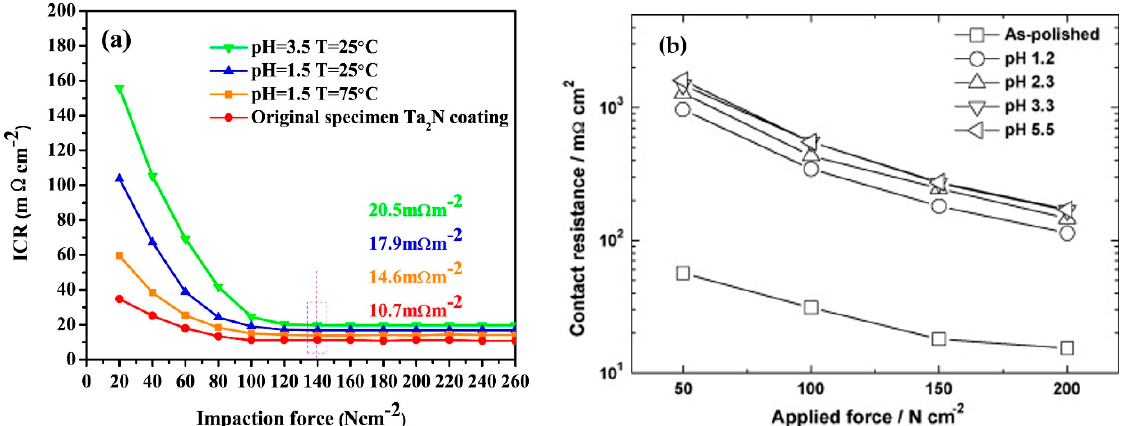
Figure 13. ( a ) Ta 2 N coated Ti-Al6-V4 alloy before and after PST test in 0.05 M H 2 SO 4 with 2 ppm HF. Reprinted from [31] copyright (2016), with permission from Elsevier. ( b ) Effect of pH and temperature on contact resistance- 310S steel on 0.05